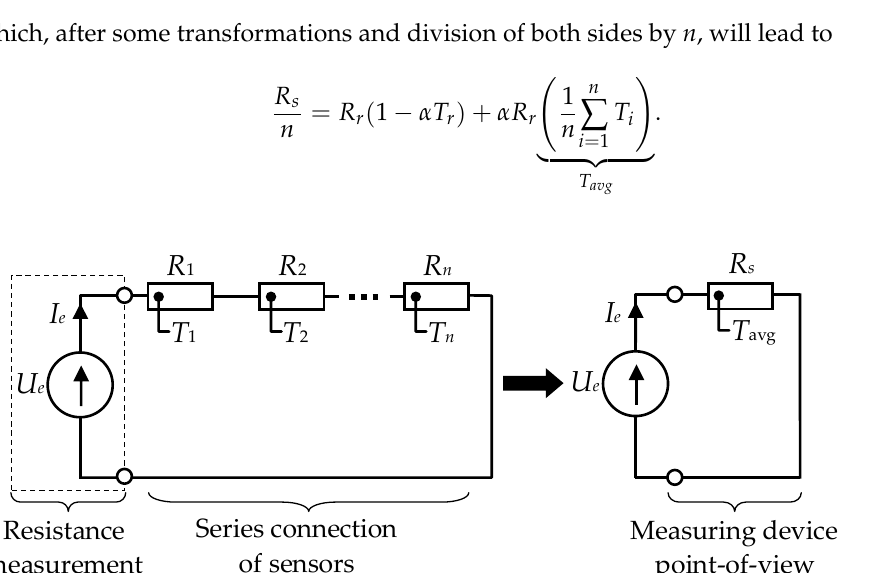
Figure 4. The series connection of several temperature sensors used for a measurement of an average temperature.